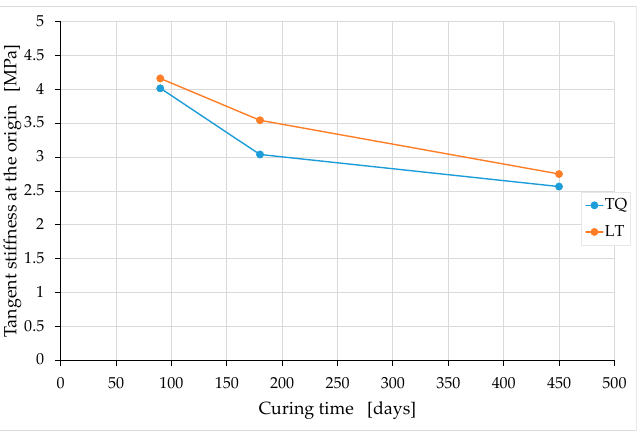
Figure 19. Trend over time of the average values of tangent stiffness at the origin: TQ and LT mixes.